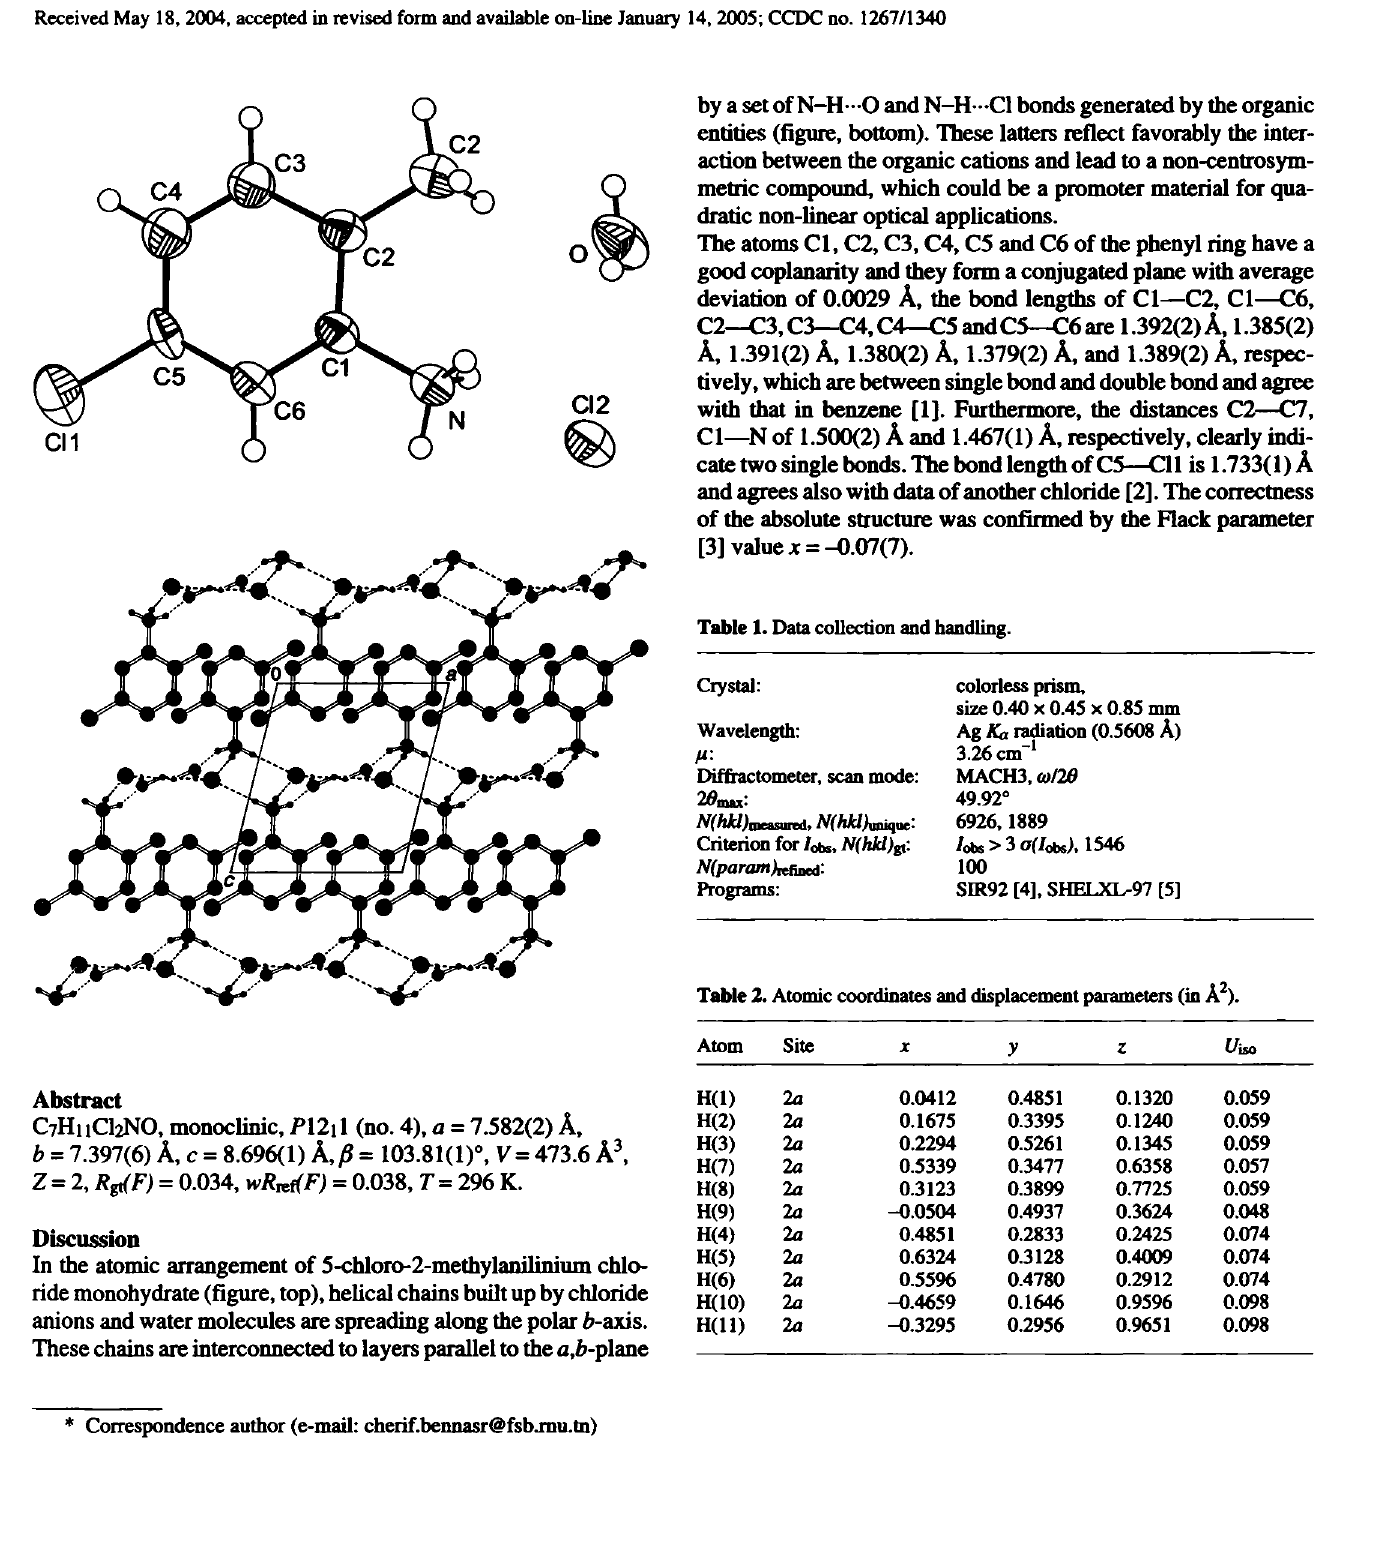
Table 1. Data collection and handling.